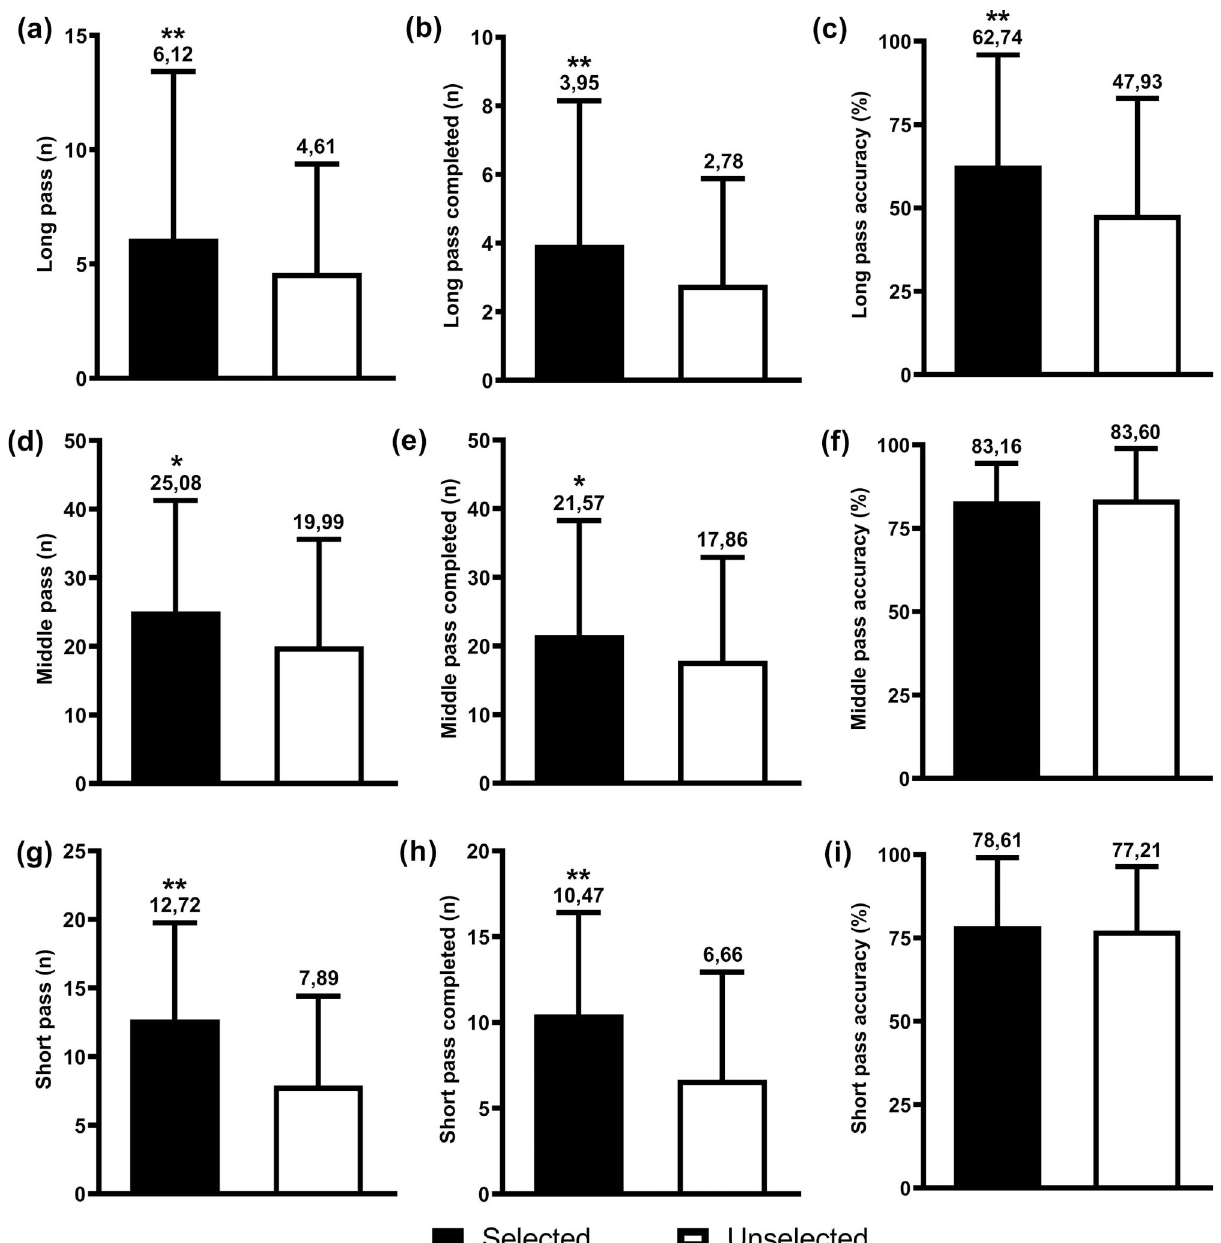
Figure 1 - Tactical variables of soccer players. Black bars: selected players. White bars: unselected players. ∗ statistically significant difference (p < 0.05); ∗∗ statistically significant difference (p